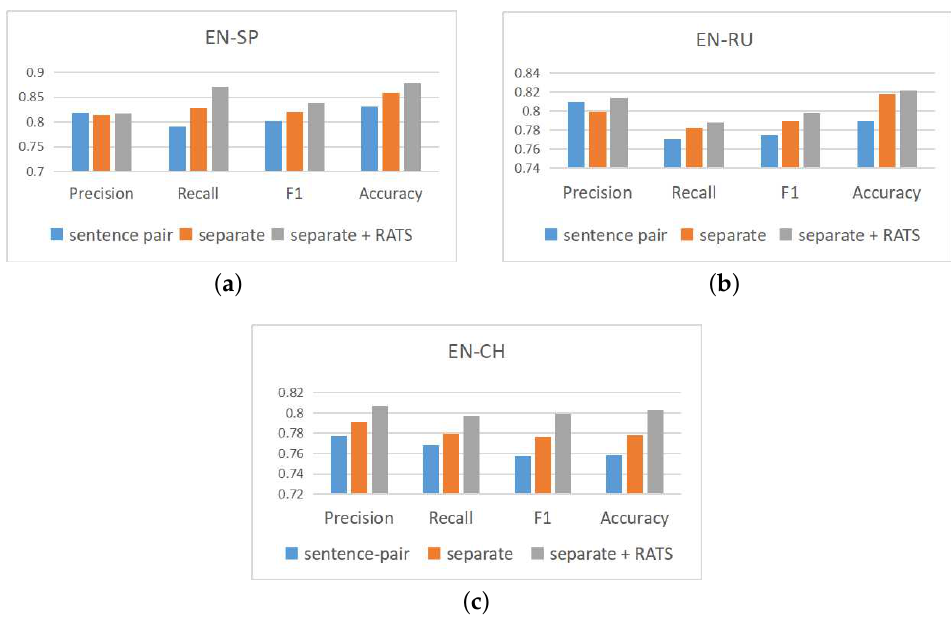
Figure 4. Comparison of models trained on sentence-pair input, separate input, and separate input with